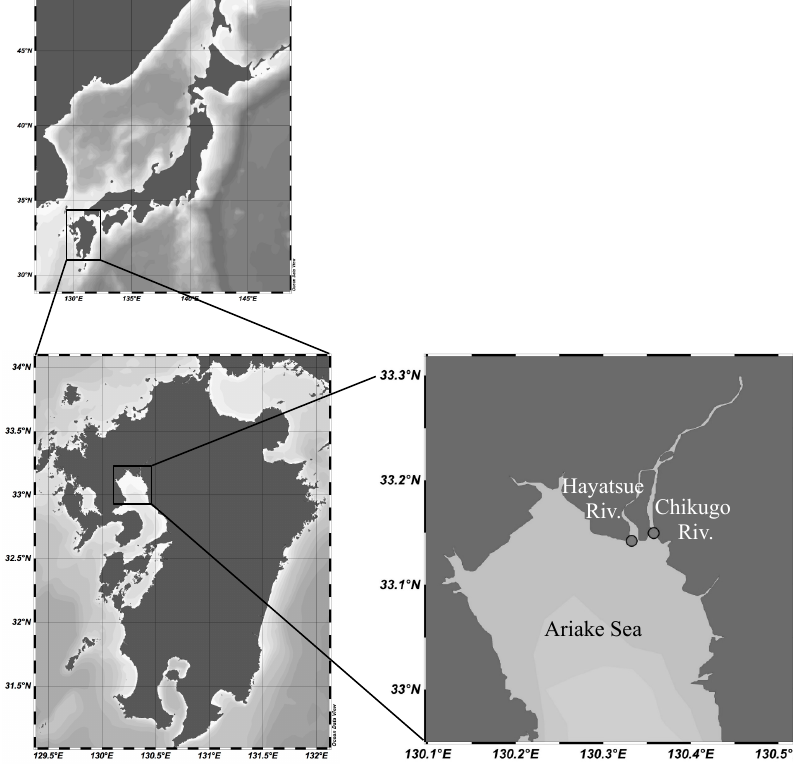
Figure 1. The study area and sampling locations.